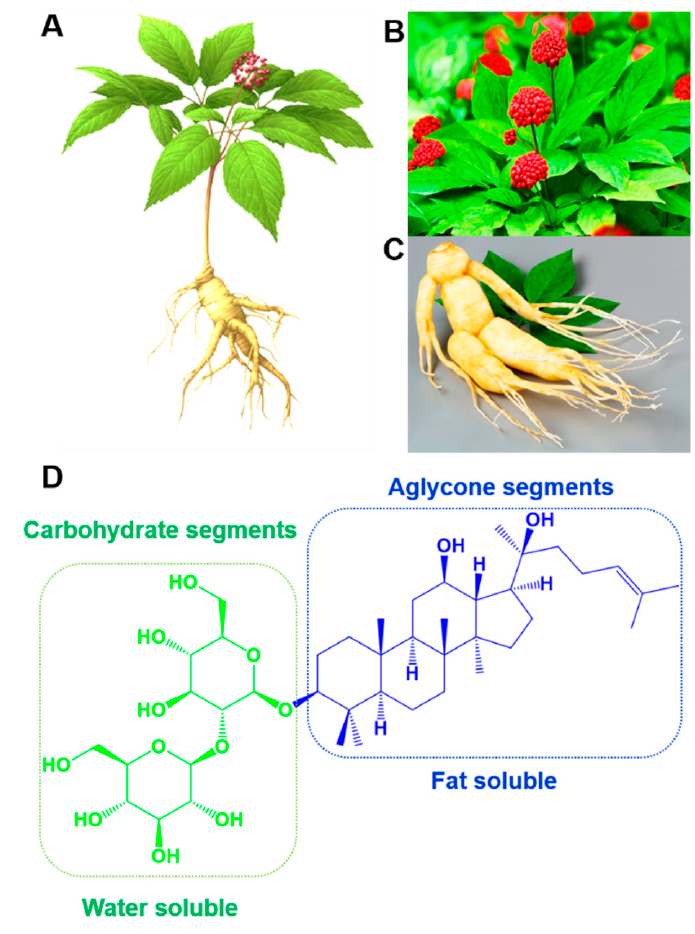
Figure 1. ( A ) Micrograph of Panax ginseng Meyer herb. ( B , C ) Berry and root of Panax ginseng Meyer herb. ( D ) Chemical structure of ginsenoside Rg3 consisting of water soluble carbohydrate and fat soluble aglycone segments.